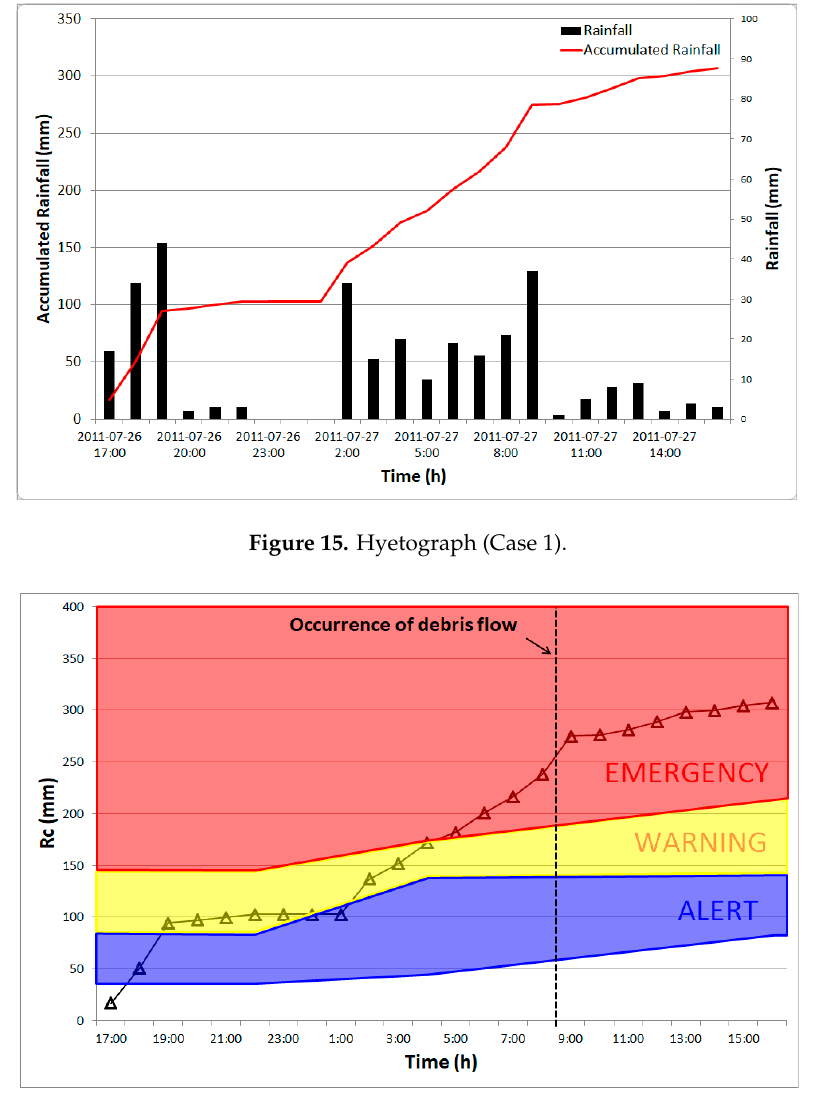
Figure 16. Debris flow forecasting using nomogram (Case 1).